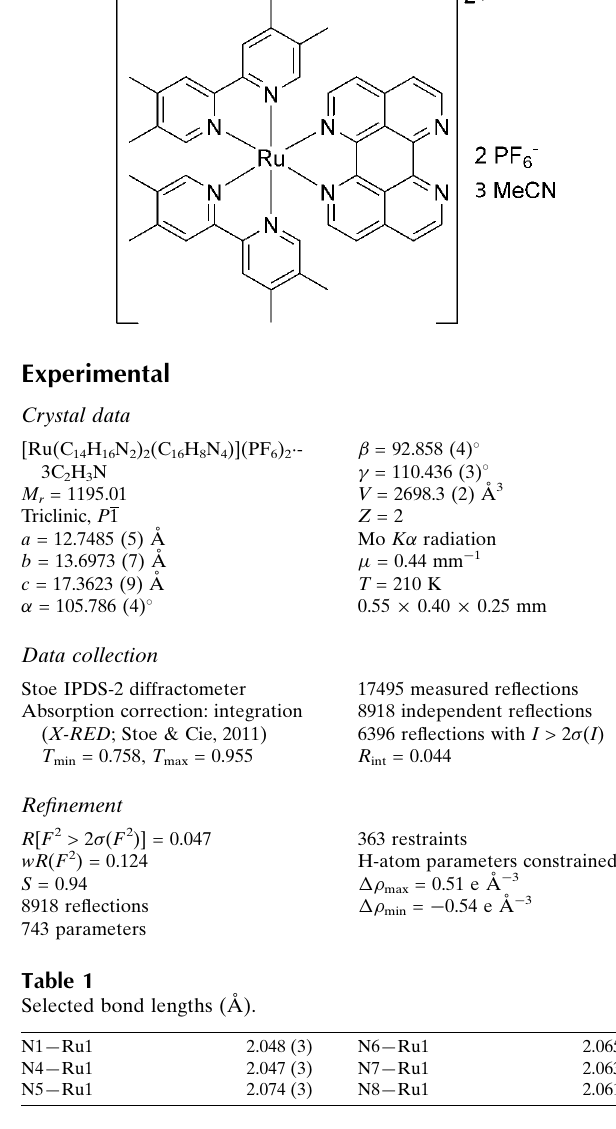
Hydrogen-bond geometry (A˚ , (cid:4)